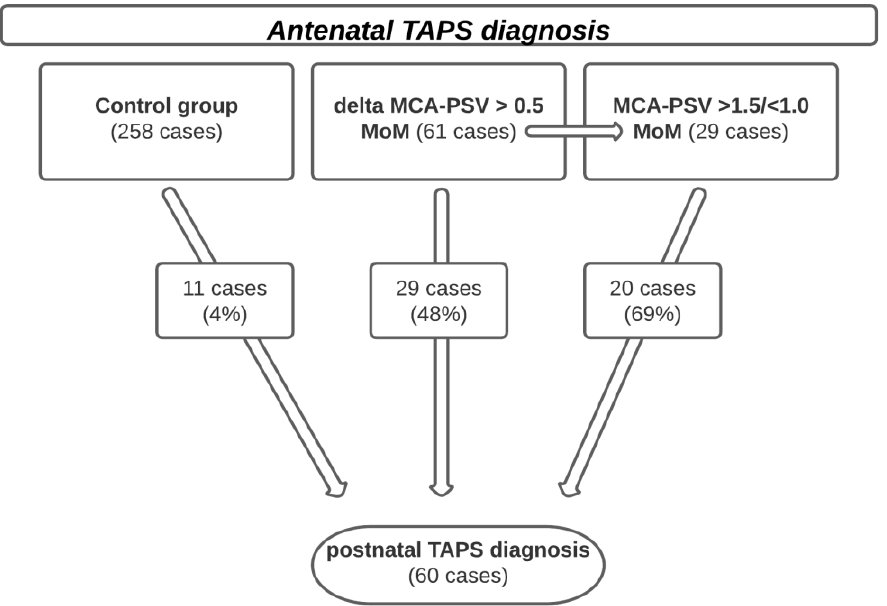
Figure 1. Shows the prenatal distribution of cases among the three diagnostic groups: the control group, the cases diagnosed as TAPS according to the criteria delta MCA-PSV > 0.5 MoM, and the cases that correspond to the diagnosis of TAPS according to the current guidelines (MCA-PSV >1.5/<1.0 MoM). Table 1. Correlation between prenatal TAPS diagnosis and postnatal TAPS confirmation. Postnatal Diagnosis of TAPS (Hb diff. >80 g/L) Yes No Total p -Value Delta MCA-PSV >0.5 MoM 49 (48%) 41 (52%) 90 (100%) <<0.001 Prenatal MCA-PSV > 1.5/<1.0 MoM 20 (69%) 9 (31%) 29 (100%) <<0.001 undetected TAPS cases 11